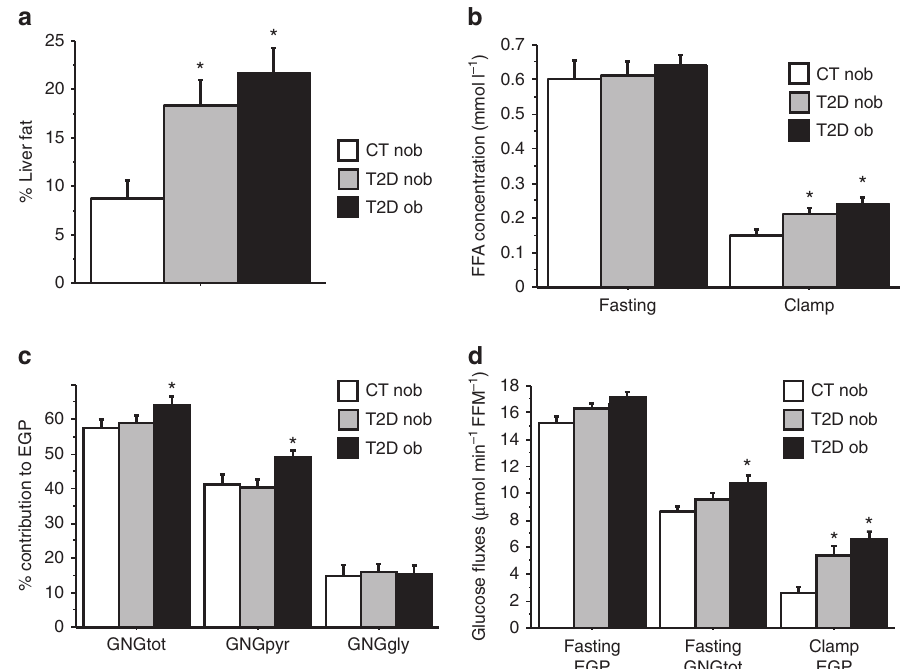
Figure 4 | Gluconeogenesis in nonobese (nob; N ¼ 24) and obese (ob; N ¼ 19) type 2 diabetic patients (T2D) and nondiabetic ( N ¼ 14) subjects, based on data from an earlier study 28 . ( a ) Liver fat percentage and ( b ) free fatty acid (FFA) concentrations in the three study groups. ( c ) Contributions of gluconeogenesis to endogenous glucose production. ( d ) Glucose fluxes in the three study groups.CT, non-diabetic non-obese control subjects; EGP, endogenous glucose production; FFM, fat-free mass; GNG, gluconeogenesis; GNGgly, GNG from glycerol; GNGpyr, GNG from lactate/pyruvate; GNGtot, total GNG. Data reported as mean ± s.e.m., * P o 0.05 ( t -test versus CT).